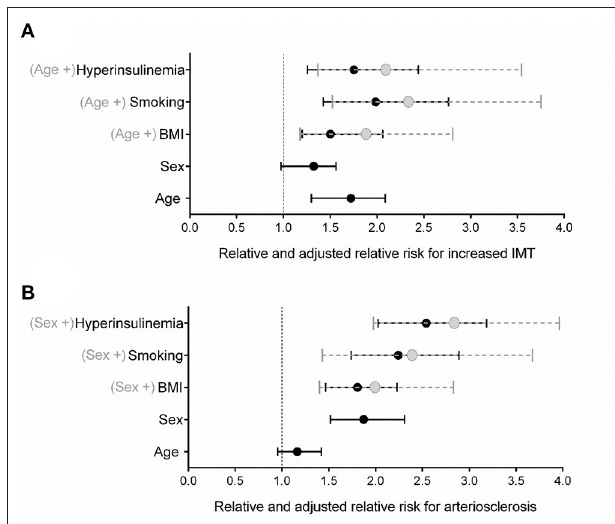
FIGURE 3 | Relative and adjusted relative risk of major risk factors for (A) increased IMT and (B) arteriosclerosis. Relative risk [mean and 95% CI (in black)] and adjusted relative risk [mean and 95% CI (in gray)] were determined by using Mantel-Haenszel analyses. Prior analysis, parametrical variables were redefined into dichotomous variables including age ( > or ≤ 44.5 years), overweight ( ≥ 25 kg/m ² BMI), and hyperinsulinemia ( > 15 µ U/ml fasting